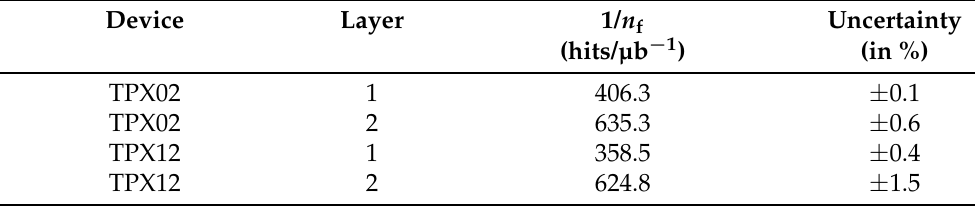
Table 24. Normalization (1/ n f ) to convert hit rates to luminosities. The larger values are for the thicker sensor layer. The relative uncertainties with respect to the 18 and 27 May 2016 measurements are also listed. Taken from Ref.